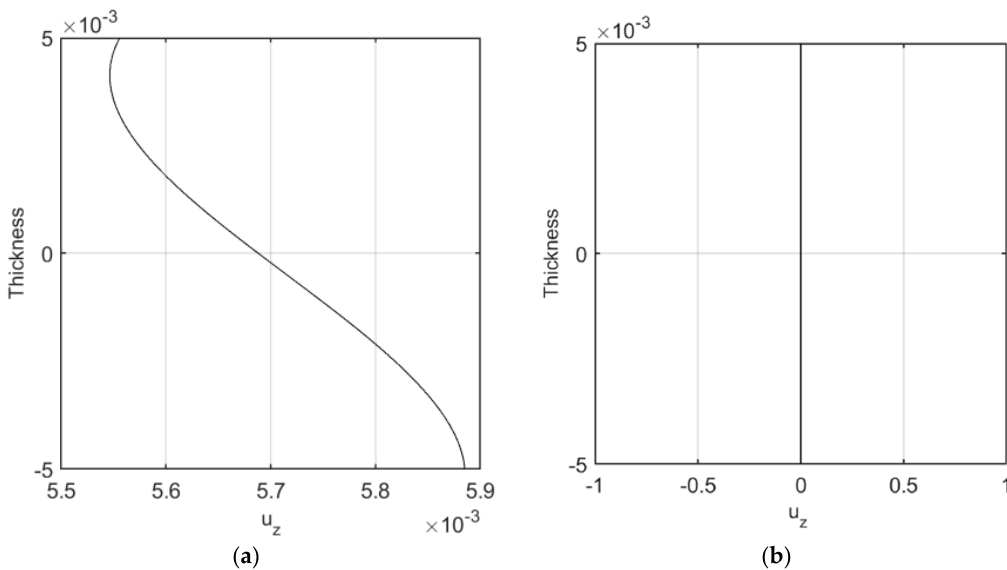
Figure 13. Maximum values of the radial deformation along the thickness direction at different longitudinal positions, at ( a ) x = 0.25 and ( b ) x = 0.5.